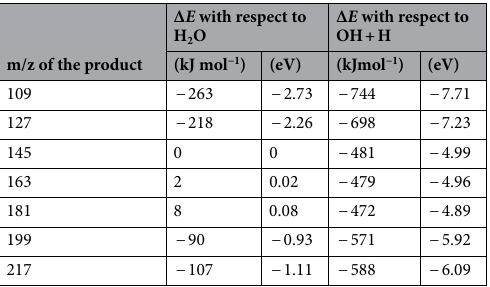
Table 1. Calculated reaction energies for H 2 O and OH + H addition to selected glucose fragments.